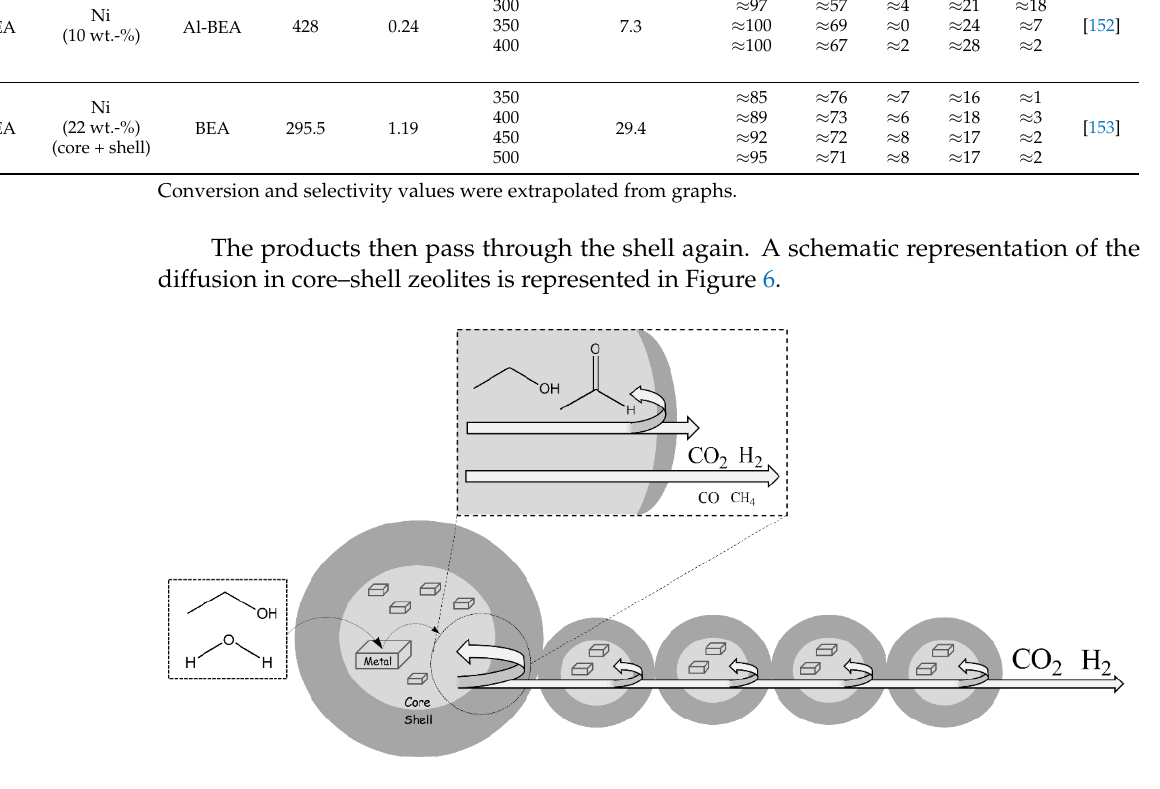
Figure 6. Schematic representation of the ESR reaction over the core–shell system (adapted from